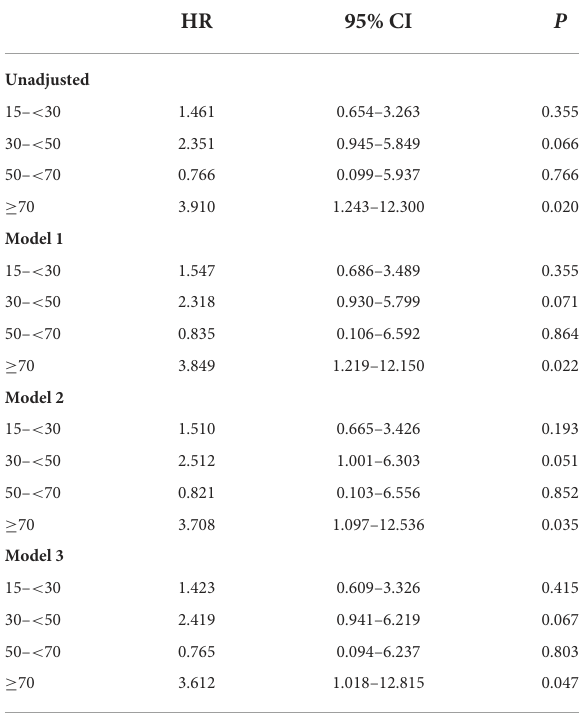
Model 1: adjusted for age, gender. Model 2: adjusted for model 1 plus history of hypertension, diabetes, atrial fibrillation, and coronary heart disease. Model 3: adjusted